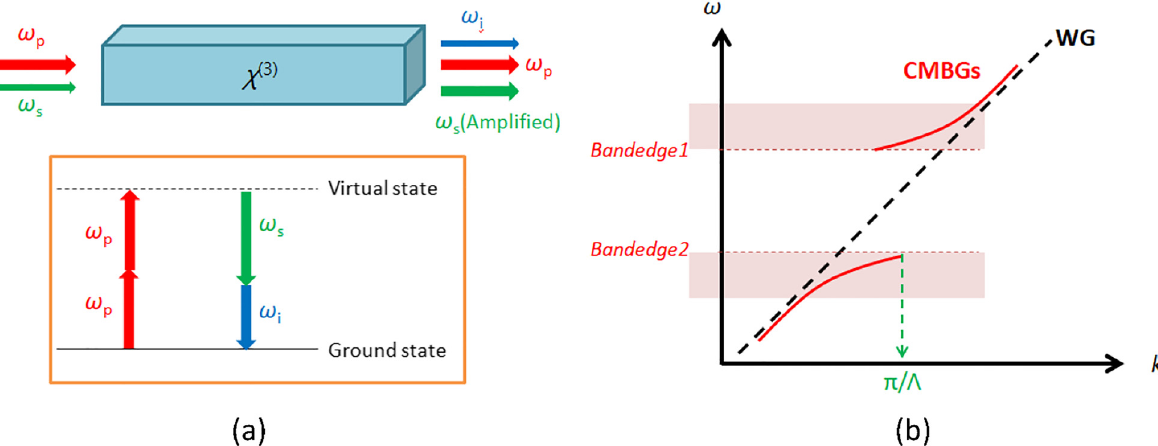
Figure 1: (a) Energyconservationin degenerateFWM process. Twopump photonsare converted into signalandidler photons.In a stimulated case, the signal wave is amplified while idler waves are generated. Momentum conservation (phase-matching) should be satisfied to fulfill amplification of signal waves and generation of idler waves. (b) Effective index near the band edges of photonic bandgap in the CMBGs structure.TheslopesofredsolidandblackdashedlinesdepicteffectiveindicesinrespectiveCMBGsandphotonicnanowirewaveguide(WG), where Λ is the period pitch of a